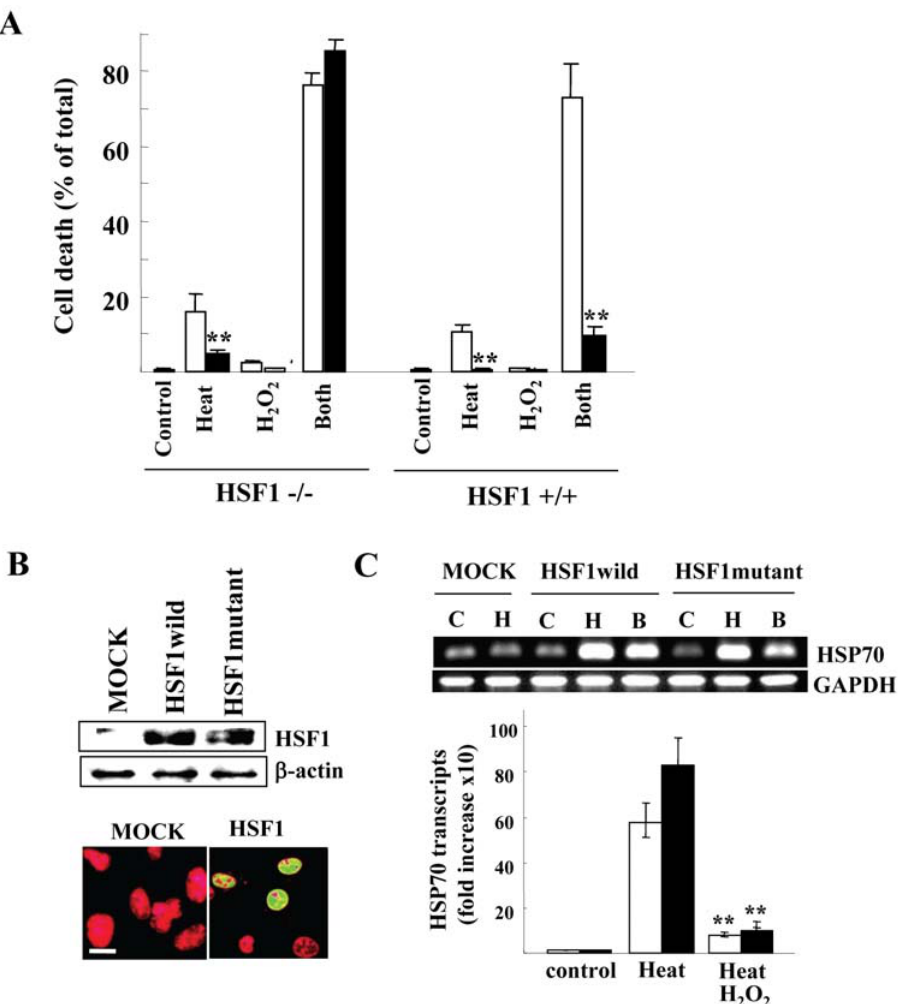
Figure 7. Effect of thermal preconditioning on H 2 O 2 -treated HSF + / + and --/- MEFs. A ) Cell death at 24 h after indicated treatments with (closed) or without (open bars) thermal preconditioning. Both MEFs were treated as indicated, heat (Heat; 42.5 u c for 20 min), 0.5 mM H 2 O 2 treatment (H 2 O 2 ) and both treatments (Both). **, P , 0.01 compared with un-preconditioned cells. B ) HSF1 overexpression. The indicated HSF1 expression vectors were transfected into HSF1-/- MEFs and cell lysates were harvested at 2 days after transfection. b -actin demonstrates equal loading of protein samples (upper). Nuclear localization of HSF1 in HSF1-rescued MEFs was evaluated by confocal microscopy. The nucleus was counterstained with PI and bar indicates 10 m m. (lower panel). C ) HSP70 transcripts were evaluated by RT-PCR transcription in cells 1 h after exposure to heat alone (H; 42.5 u c 20 min), heat after 0.5 mM H 2 O 2 pretreatment (B) or untreated cells (C). GAPDH mRNA levels ensure that the RNA was correctly quantified (upper). After indicated treatments, HSP70 transcripts in transfectants expressing wild-type (open) or mutant HSF1 (closed bars) were determined by real-time PCR and normalized to GAPDH levels (lower panel). **, P , 0.01 compared with H 2 O 2 -untreated cells. In A and C , error bars indicate the mean 6 S.D. of data from three separate experiments